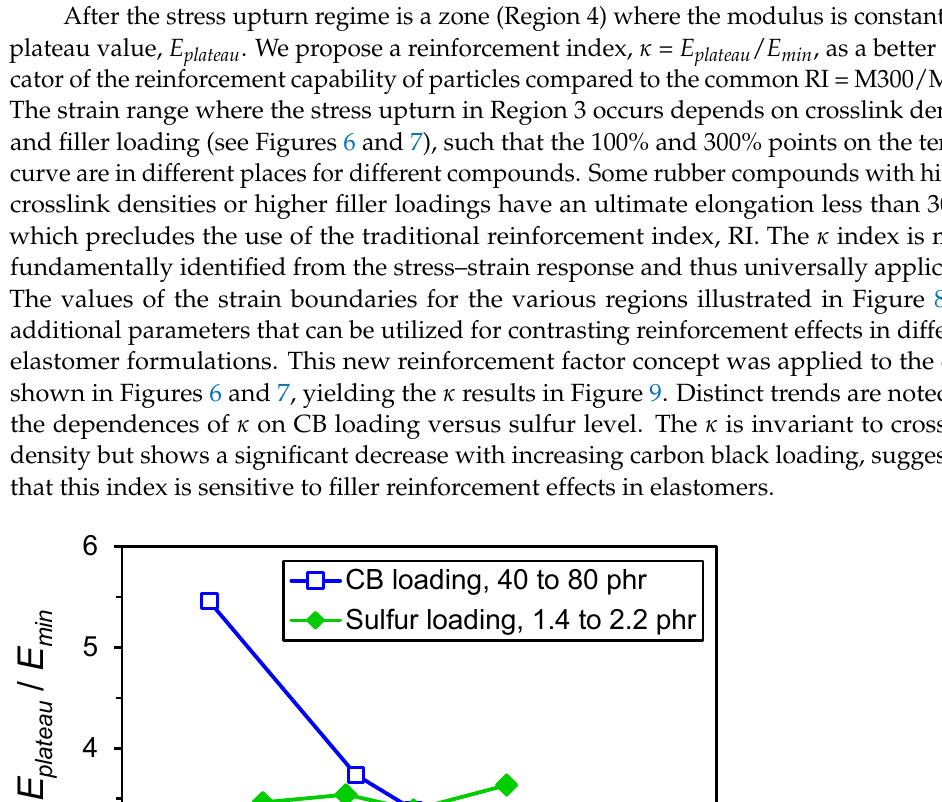
Figure 9. Robertson–Hardman reinforcement index κ determined from the literature data [11] shown in Figures 6 and 7.